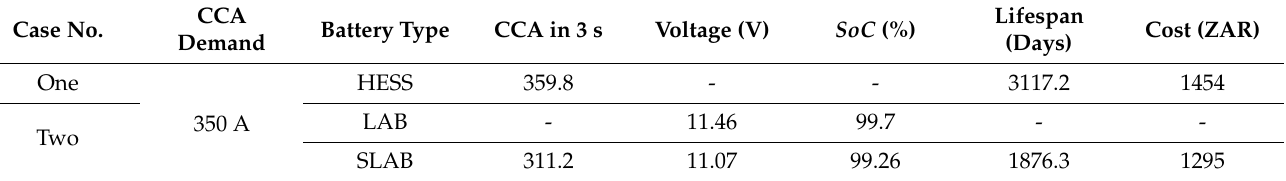
Table 9. The summary of the results for the proposed HESS in different operating conditions.